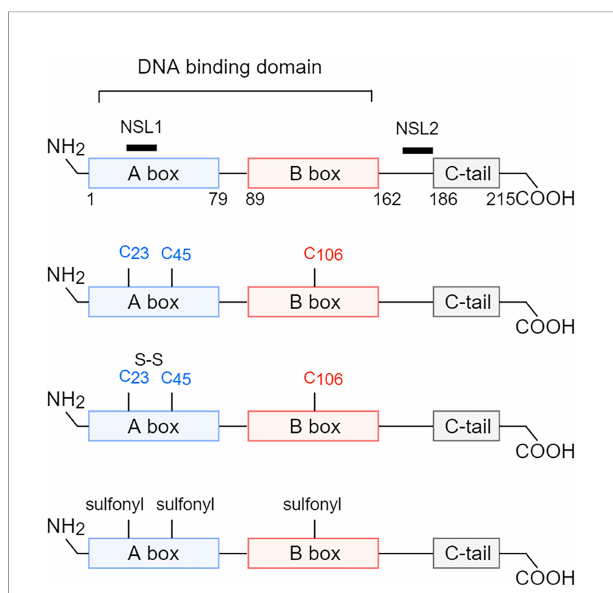
FIGURE 1 | Structure and redox reaction of HMGB1. HMGB1 is composed of A box, B box, c-terminal tail, two nuclear localization sequences (NLS1, 27-43 AA; NLS2, 178-186 AA), and two homologous L-type DNA-binding regions. HMGB1 has three cysteine residues, Cys23, Cys45, and Cys106, and has three different redox forms. When all three cysteine residues are in reduced form, the main extracellular function of HMGB1 is chemotaxis. When Cys23 and Cys45 form intramolecular disul fi de bonds, and Cys106 is in reduced form, the main extracellular function of HMGB1 is to promote the production of proin fl ammatory factors. When all three cysteine residues are oxidized, the main extracellular function of HMGB1 is unable to induce in fl ammation. NLS, nuclear localization sequences; AA, amino acid. Cys,